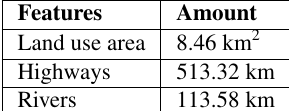
Table 6. Mapping results of the fifth course meeting. Source: resultmaps.neis-one.org/, https://mapathon.cartong.org/